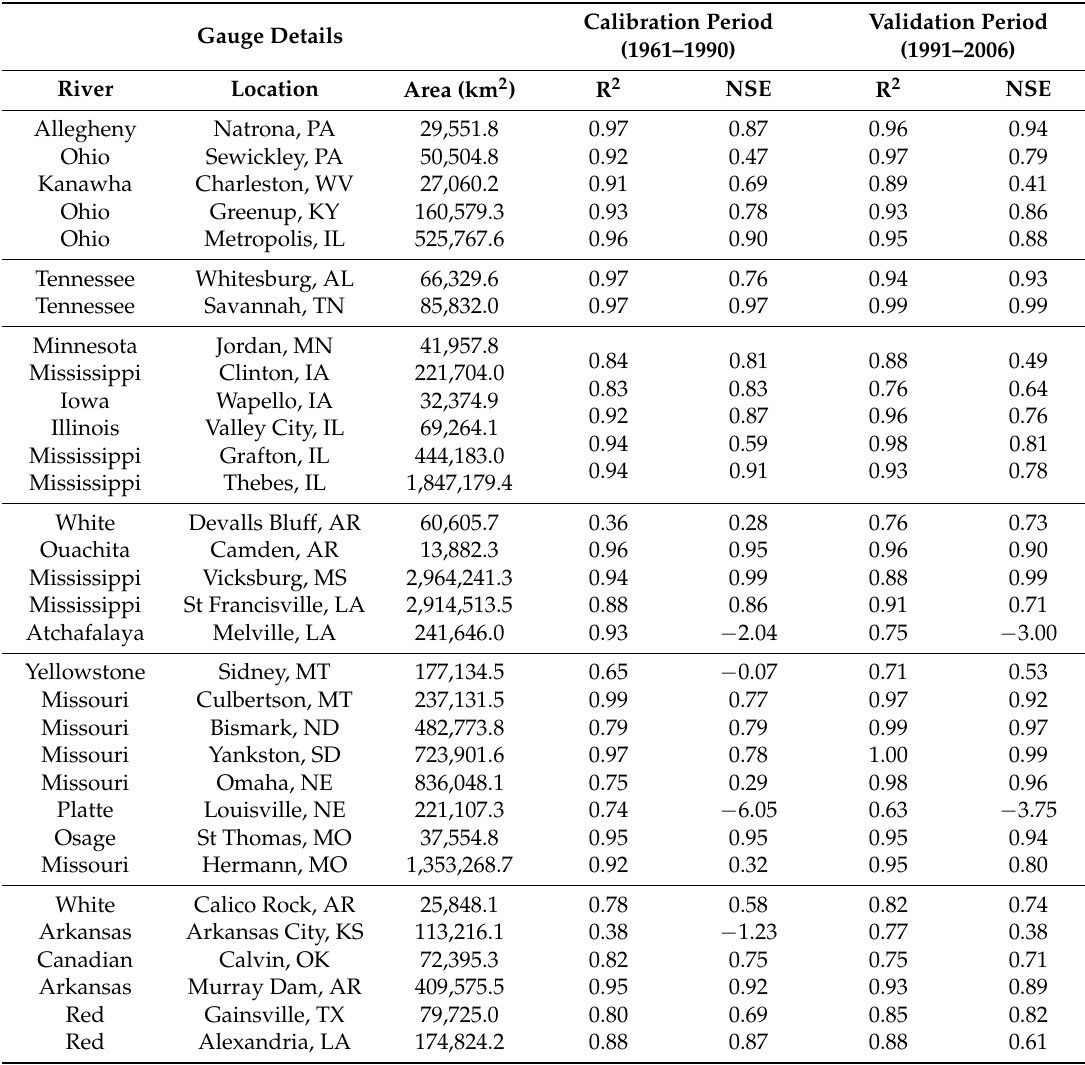
Table 2. Model performance evaluation for estimation of annual average flow